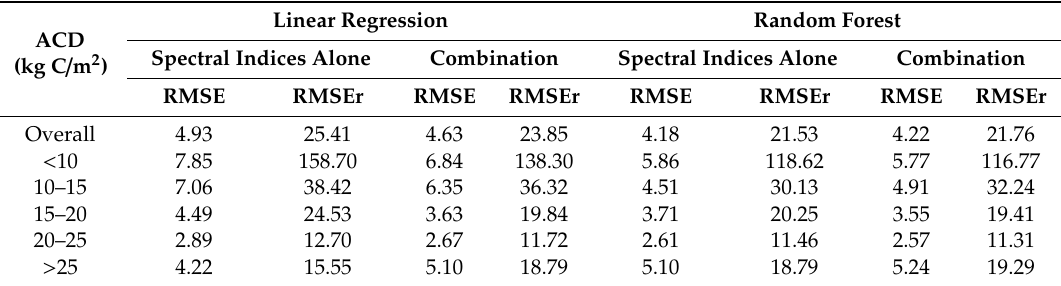
Table 7. Accuracy analysis of aboveground carbon density (ACD) modeling results based on di ff erent ACD